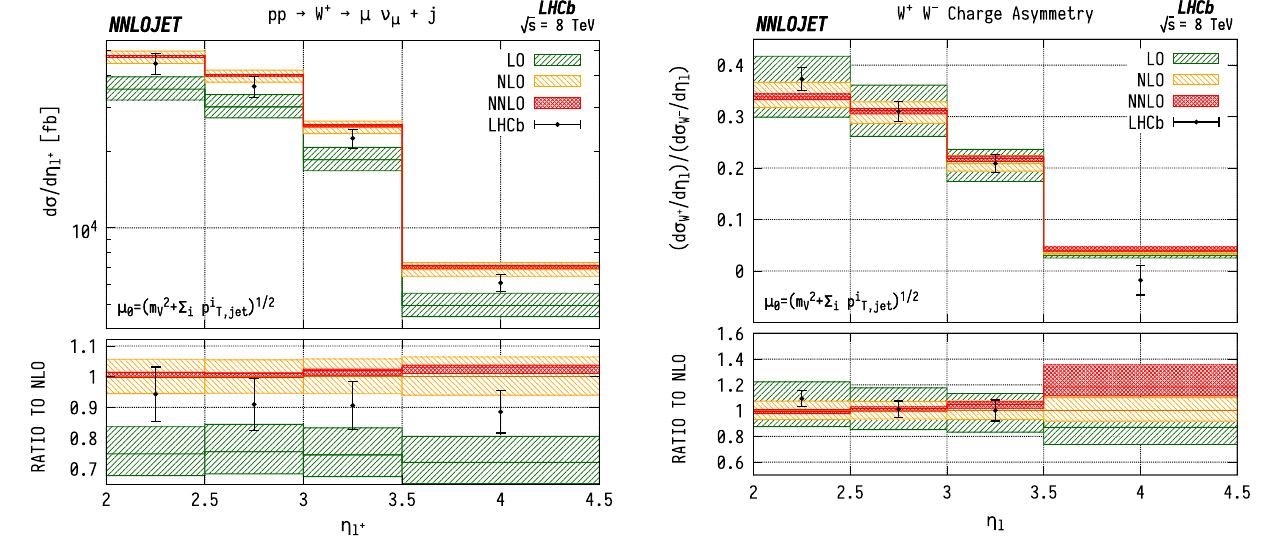
Fig. 12 W ± asymmetry in WJ production differential in the pseudo- rapidity η of the lepton produced from the W boson decay. See Fig. 3 for